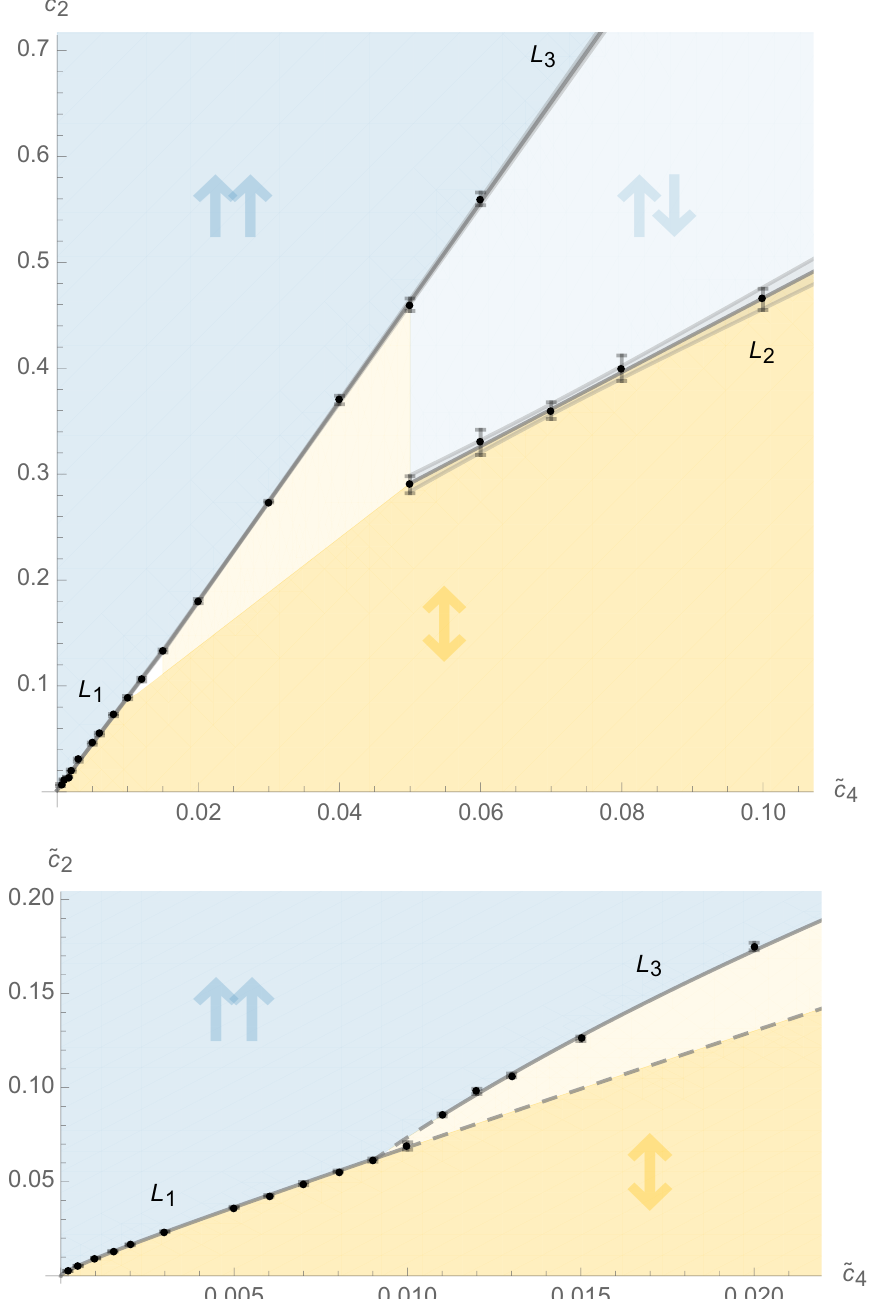
Figure 7 . Phase diagram for N = 24 . Pale-gray stripes represent 68% confidence intervals. Top diagram is constructed from peaks in C and bottom one from peaks in χ . Bottom plot shows zoomed-in region around the origin of the top plot. A pale yellow wedge between l and ↑↑ phases represents the phase coexistence region, that shrinks with increase in matrix size, and presumably collapses into a triple